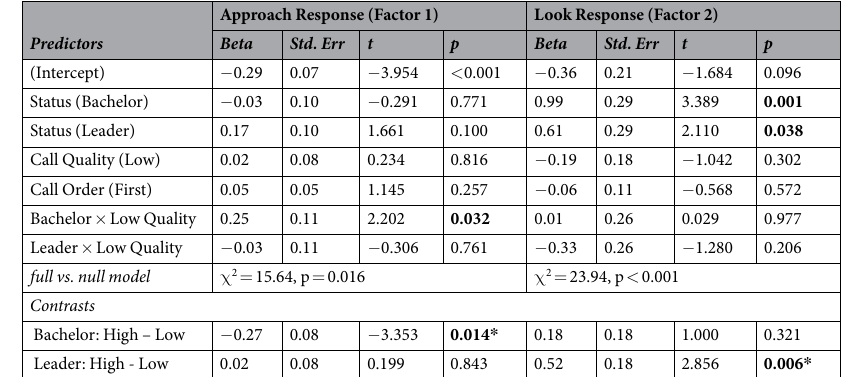
Table 2. Results from LMMs. * Bonferroni adjusted alpha level of < 0.025.